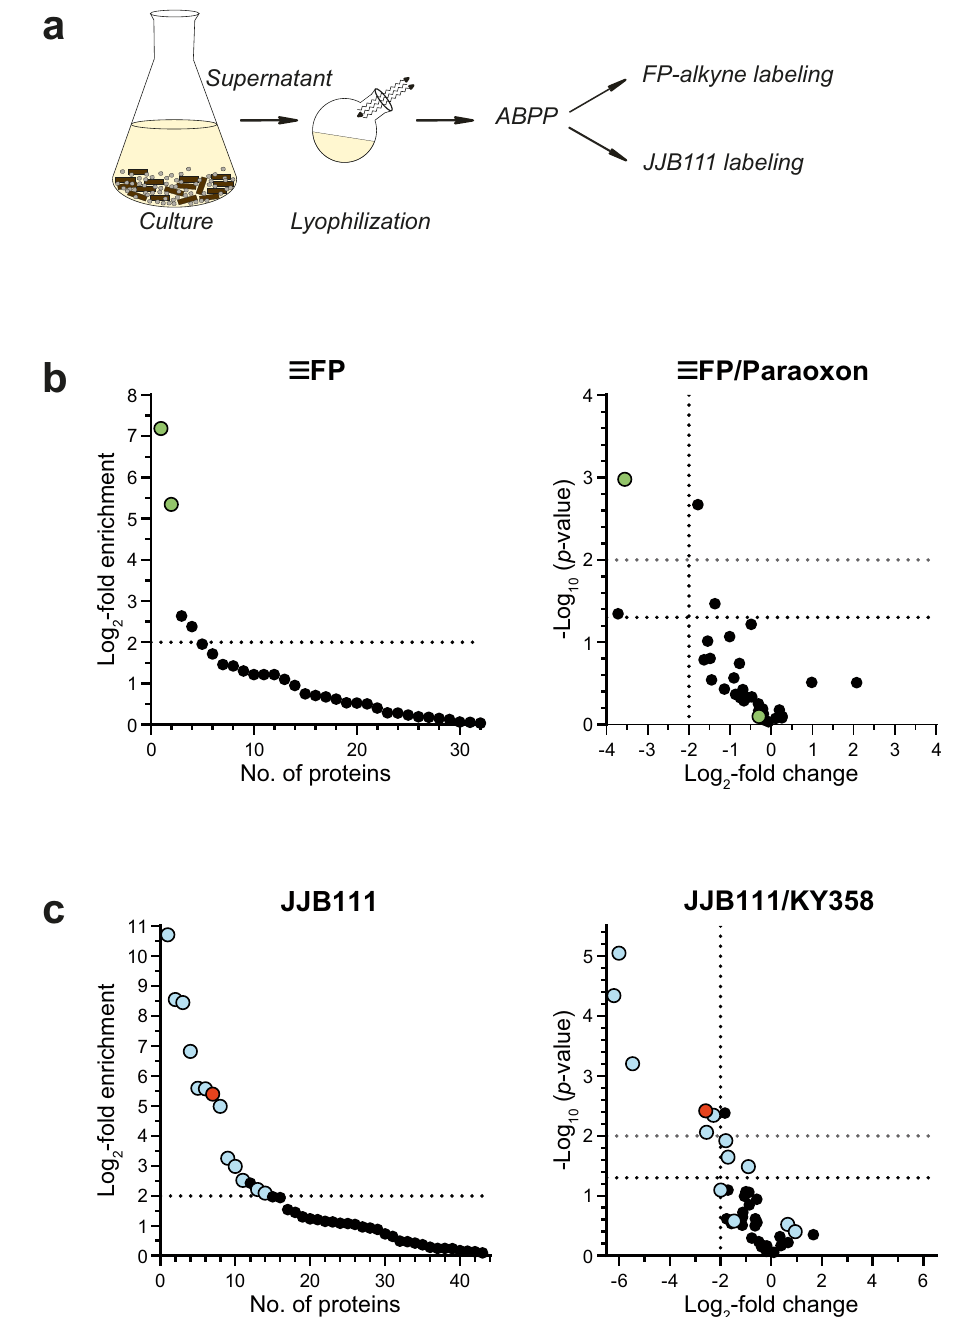
Fig. 2 ABPP of P. chrysosporium supernatants. a Work fl ow of the analysis. P. chrysosporium suspension cultures were grown for 5 days on a minimal medium supplemented with beech wood chips. The solid material was fi ltered off, the fi ltrate lyophilized, and the residue was subjected to ABPP with the corresponding probes. b ABPP of SHs without (left panel, log 2 -fold change ≥ 2 compared to DMSO is indicated) or after pretreatment with 50 µ M paraoxon (competition experiment, right panel) with 2 µ M FP-alkyne after click chemistry ( n = 4 biologically independent samples). Green dots indicate SHs. c ABPP of GHs without (left panel, log 2 -fold change ≥ 2 compared to DMSO is indicated) or after pretreatment with 20 µ M KY358 (competition experiment, right panel) with 2 µ M JJB111 ( n = 4 biologically independent samples). Blue dots indicate GHs, while the red dot represents the DUF protein with four domains of unknown function Phchr2|3002168 with potential GH